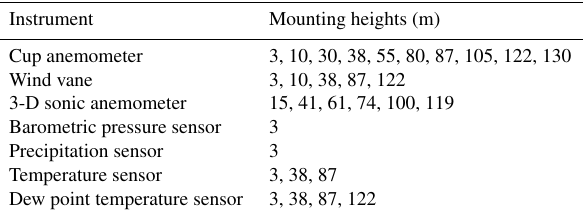
Table 1. Mounting heights of instruments on the 135m met